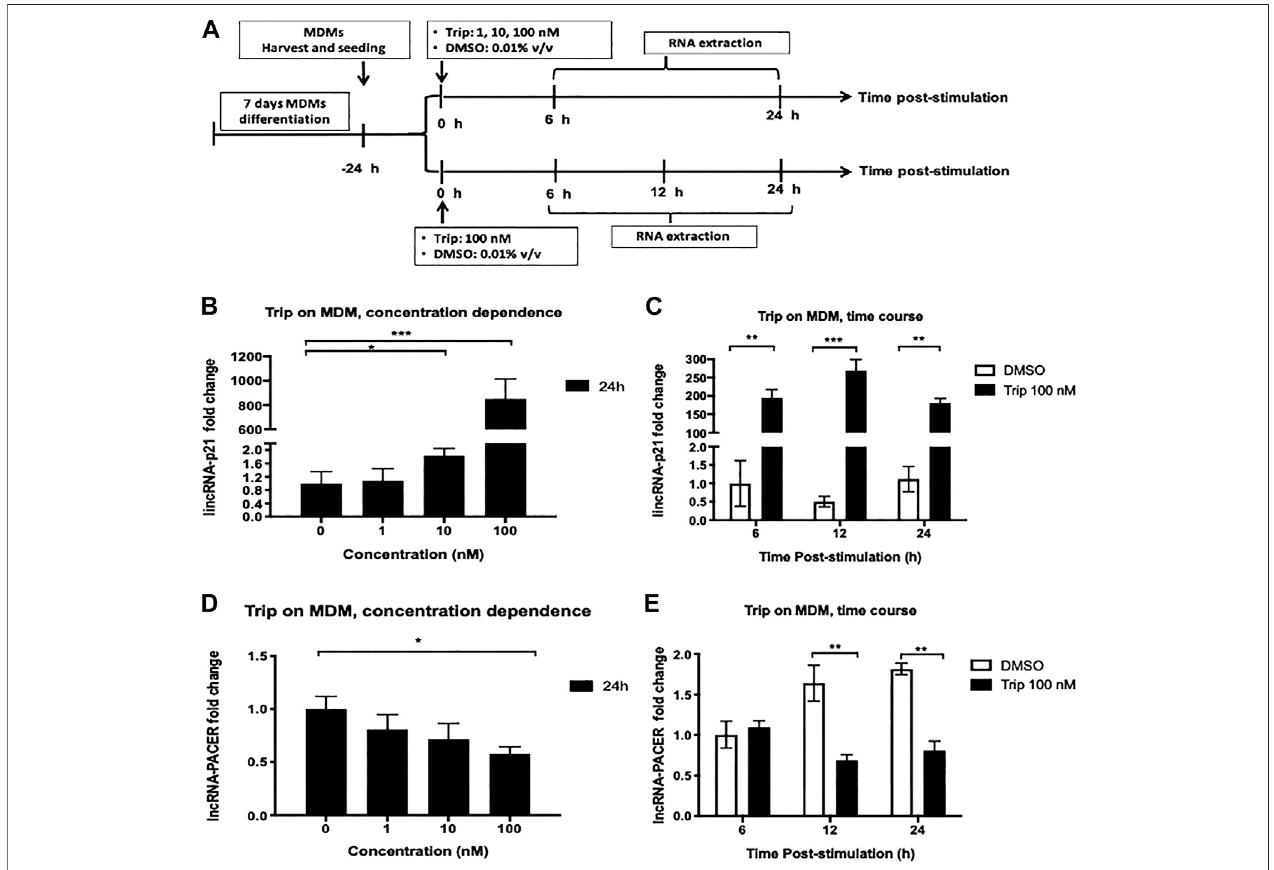
FIGURE1| Triptolidetreatmentmodulatesthe expression oflincRNA-p21 and lncRNA PACER inrestingmonocyte-derived macrophages (MDMs). (A) :Graphical summary for concentration dependence and time dependence experiments. Concentration dependence (B, D) : MDMs were treated with increasing concentrations of triptolide for 6 and 24 h. DMSO was used as a vector control. Total RNA was extracted, and then lincRNA-p21 (B) and lncRNA-PACER (D) expression levels were assessed by RT-qPCR. Time dependence (C, E) : MDMs were treated with 100 nM triptolide for 6, 12, and 24 h. DMSO was used as a vector control. Total RNA was extracted, and then lincRNA-p21 (C) and lncRNA-PACER (E) expression levels were assessed by RT-qPCR. Relative expression was calculated using the − ΔΔ Ct method. * p < 0.05; ** p < 0.01; *** p < 0.001.